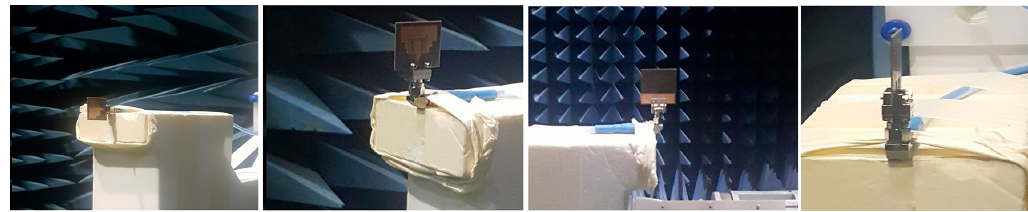
Figure 10. Radiation pattern measurement setup for the reference and proposed antenna at different orientations in the anechoic chamber.